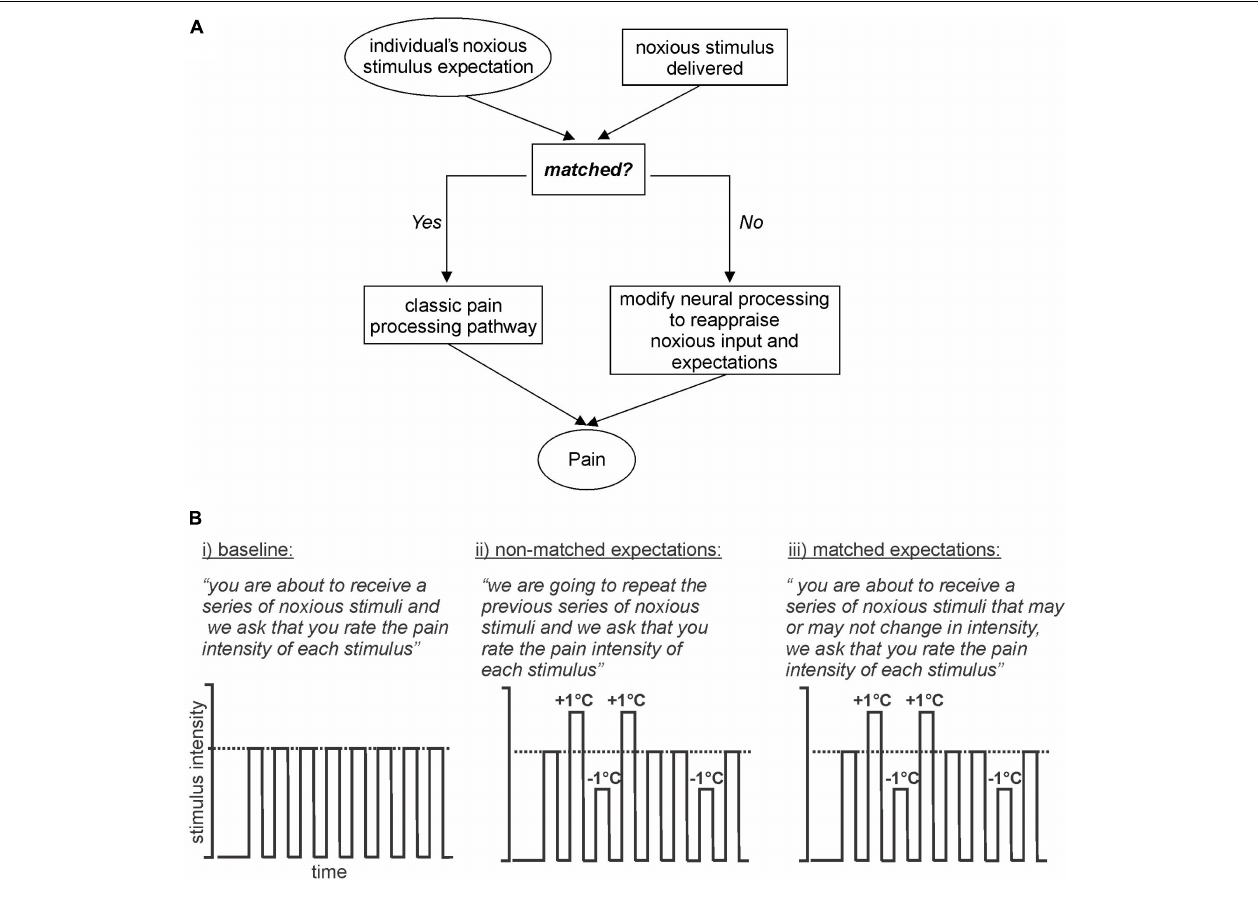
FIGURE 1 | Model and Experimental design. (A) Model: basic model via which expectation of an incoming stimulus is either matched or not matched to an individual’s expectation. If the stimulus and expectations are not matched then the conflict is reappraised. (B) Experimental design: (i) baseline: subjects are expecting a series of noxious stimuli and that is what they receive; (ii) non-matched expectations: subjects expect a series of noxious stimuli of equal intensity, however, the intensities are varied up and down by 1 ◦ C; (iii) matched expectations: subjects expect a series of noxious stimuli of potentially varying intensities and they receive varied stimulus intensities, the same series as delivered in the previous